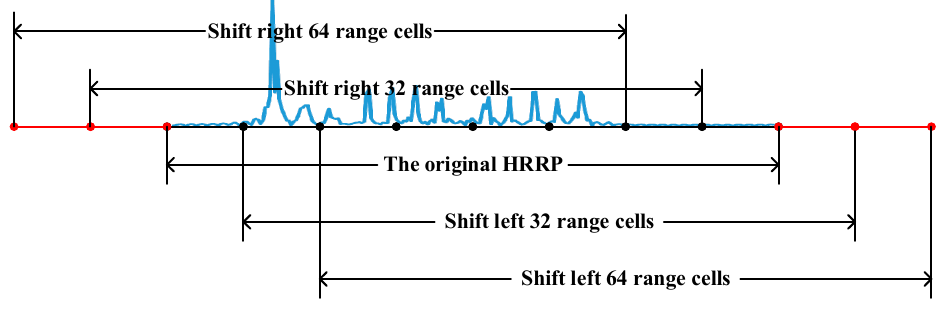
Figure 7. Interception of the HRRP.